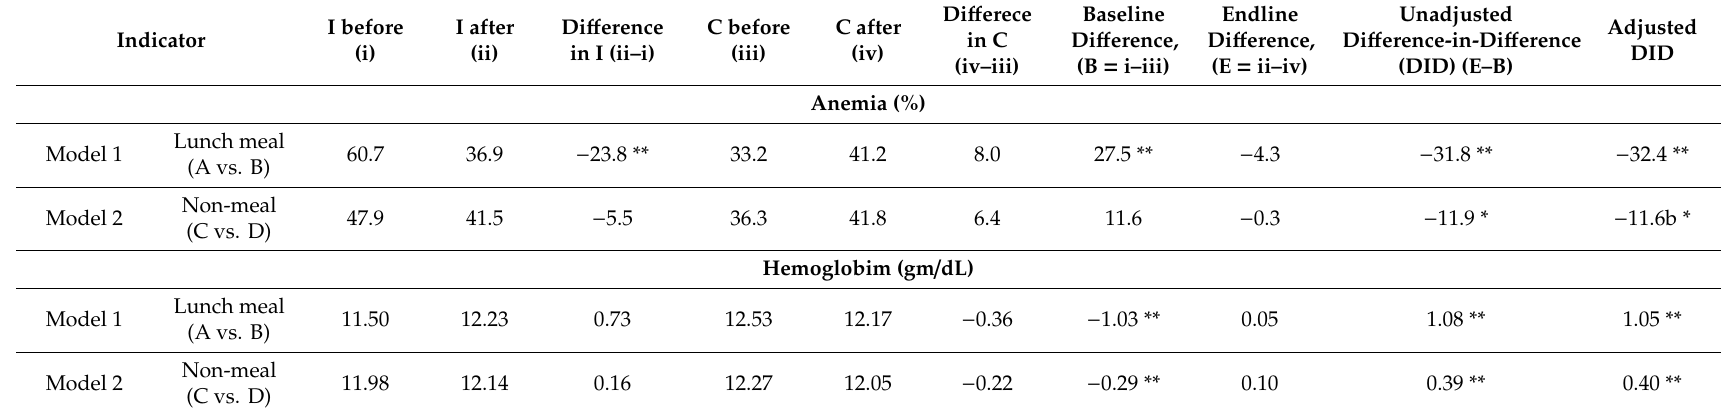
Table 6. E ff ect of intervention on anemia (% of women with any anemia) and hemoglobin concentration (gm / dL): DID